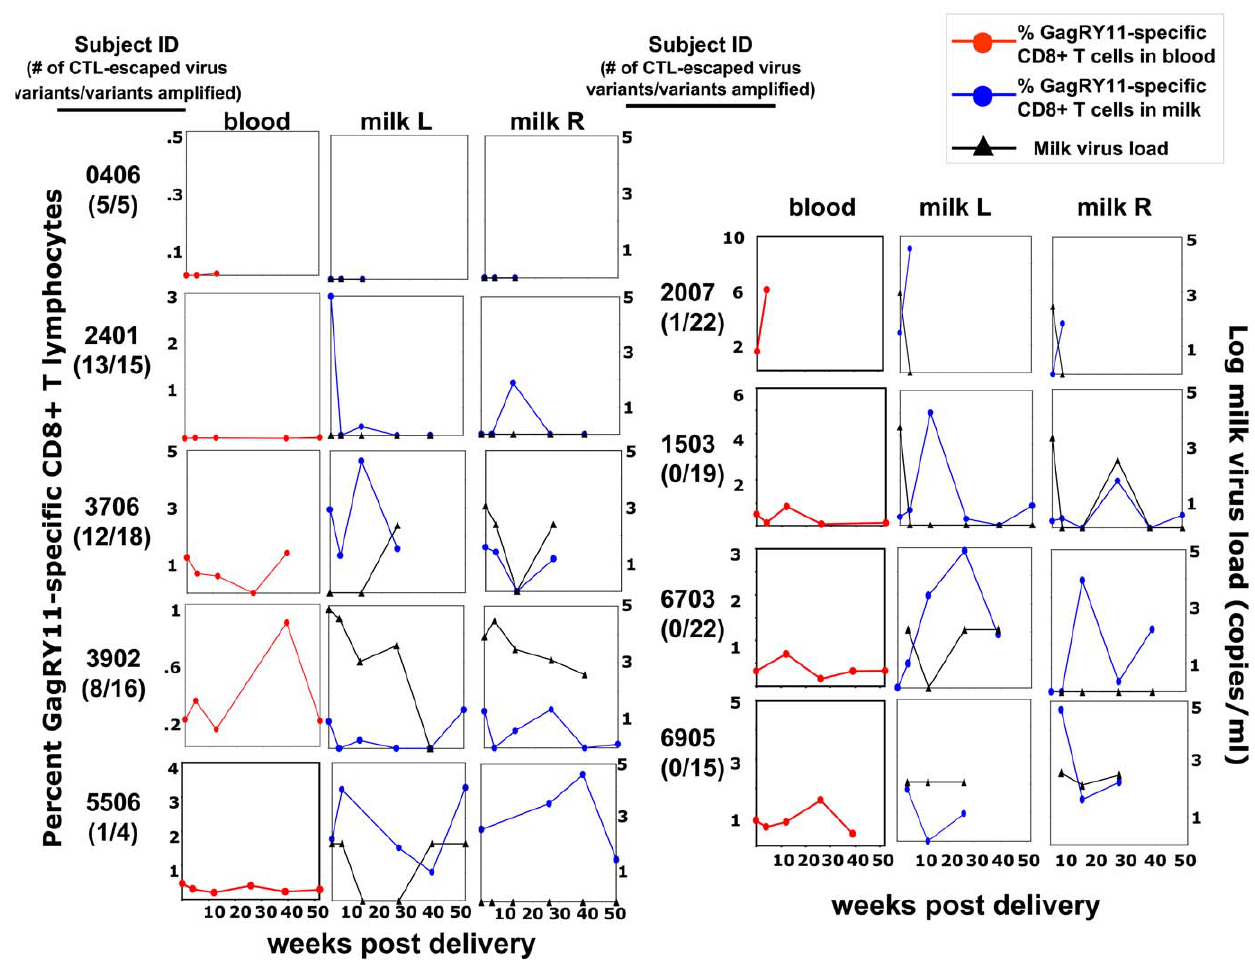
Figure 3. Variable relationship between the kinetics of the immunodominant GagRY11-specific CD8 + T cell response in milk (blue circles) and that in blood (red circles), as well as between the GagRY11-specific CD8 + T cell response in milk and the breast milk virus RNA load (black triangles) in HIV-infected, lactating women. The plots of GagRY11-specific CD8 + T lymphocyte responses and virus load in blood (red circles) and milk of left and right breast (blue circles) from each subject are ordered by decreasing proportion of CTL-escaped plasma virus variants. Milk virus RNA load from each breast (black triangles) is plotted with the GagRY11-specific CD8 + T lymphocyte responses in each breast.